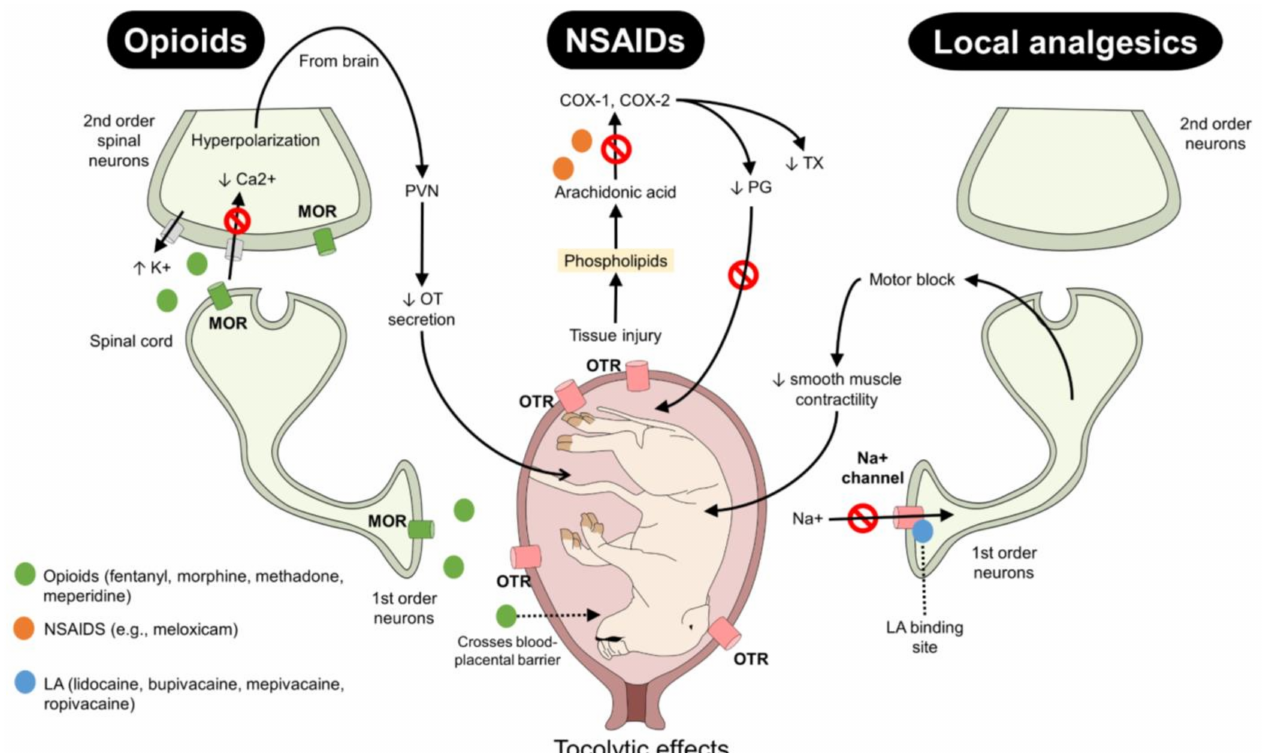
Figure 3. Action mechanisms of opioids, NSAIDs, and local analgesics. During labor, all three types of analgesics exert their action by interacting with various receptors and metabolic